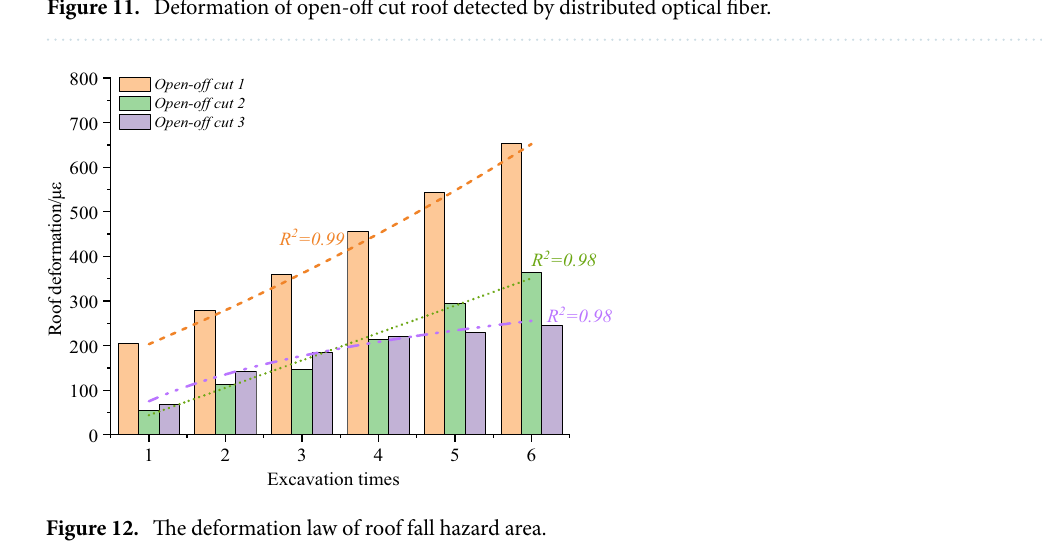
Figure 12. The deformation law of roof fall hazard